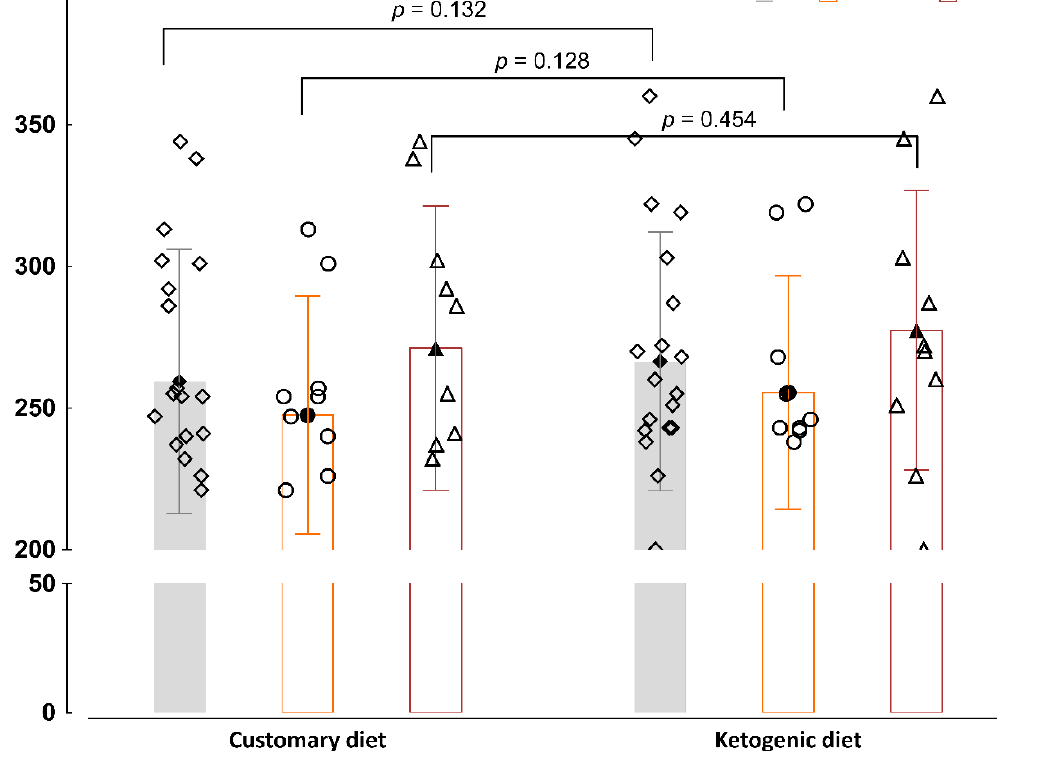
Figure 3. Total score in the Fight Gone Bad (FGB) test. Values are expressed as the mean (black fill) ± standard deviation and raw data (white fill). All: ◊ , females: O, males: ∆ . Data were analysed by repeated-measures one-way analysis of variance. Statistical significance was set at p < 0.05.